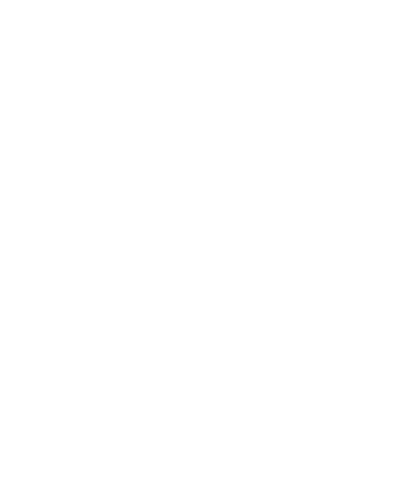
Figure 11. Photocatalytic mechanism of hexagonal frame TiO 2 (e − represents an electron; h + repre- sents a hole).